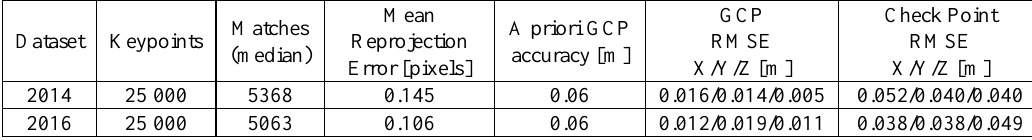
Table 3. Results of bundle adjustment in Pix4D for both datasets.